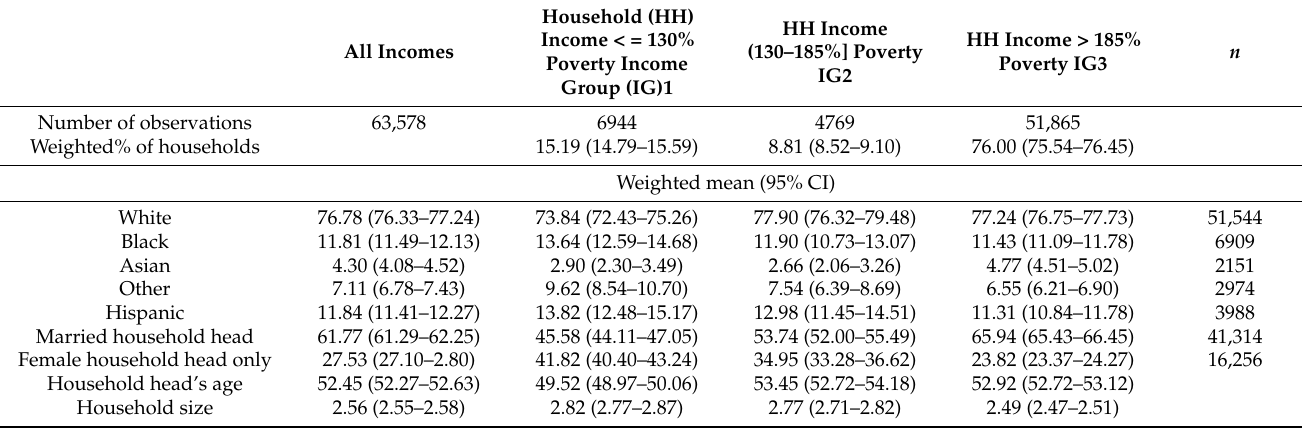
Table 1. Household characteristics, overall and by poverty level, based on Information Resources Inc. (IRI) Consumer Network 2015 data.